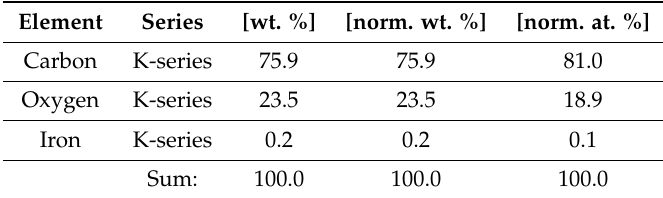
Table 3. Energy dispersive X-ray spectroscopy (EDX) mapping data for oxidized multiwalled carbon nanotubes (OMWCNT).